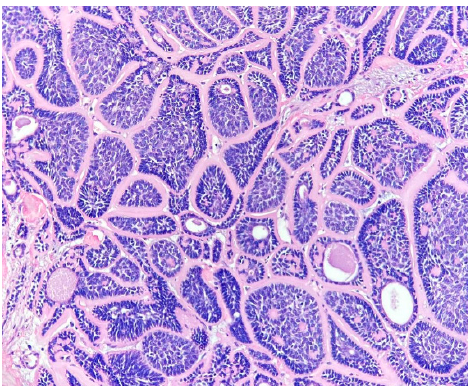
Figure 10. Cylindroma (tumoral islands made of two distinct cellular populations arranged in a “puzzle”.